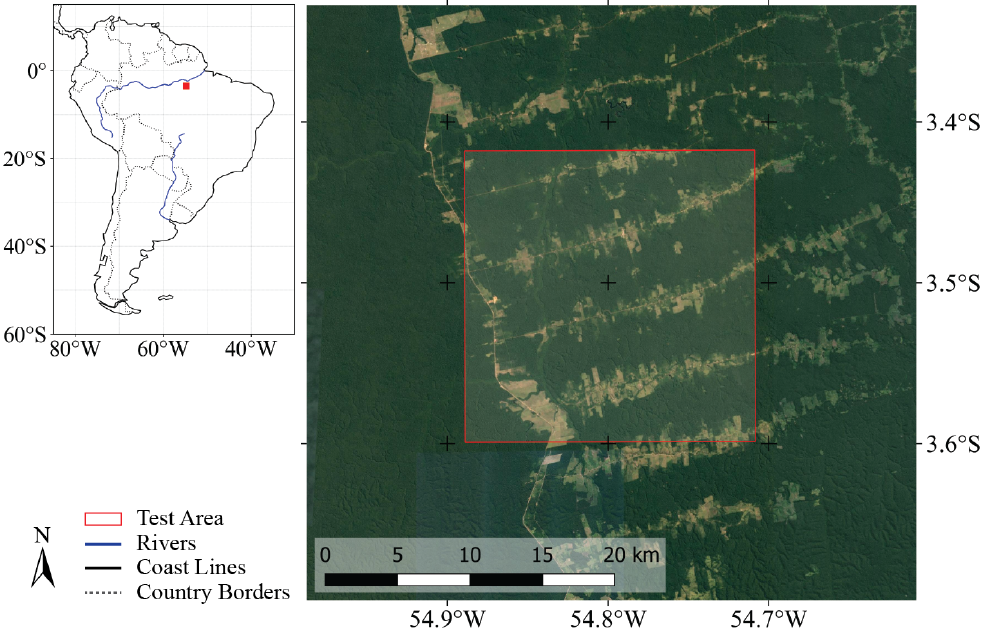
Figure 4. The region of interest with the 20km × 20km area (the red rectangle) selected for testing the openEO UDF workflow on the EURAC backend and locally. The base image is a Google Earth satellite image (Imagery ©2021, TerraMetrics, Map data